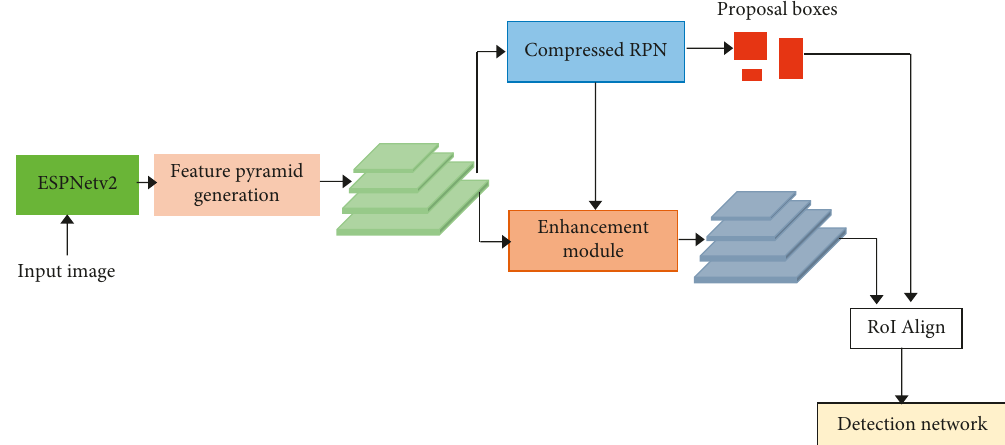
Figure 1: Overall structure of the proposed